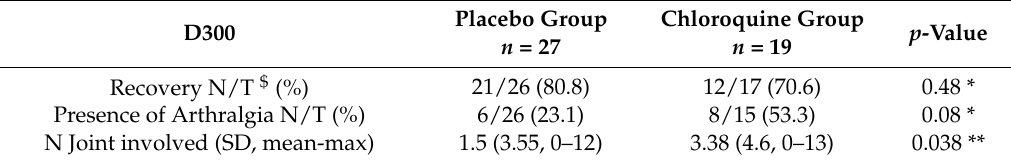
Table 2. CHIKV-patient clinical status at Day 300 post